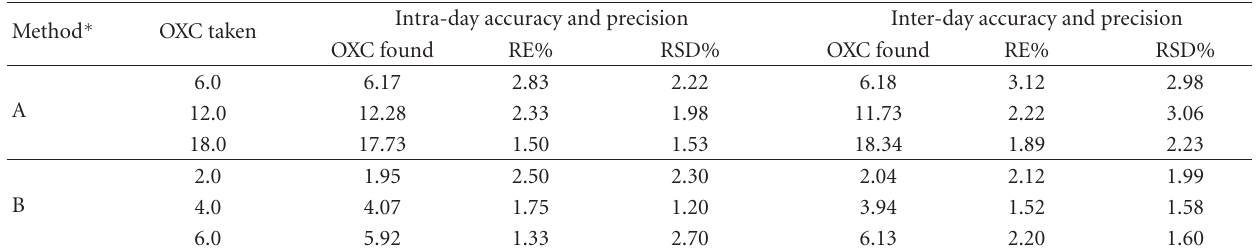
Table 1: Intraday and interday accuracy and precision.